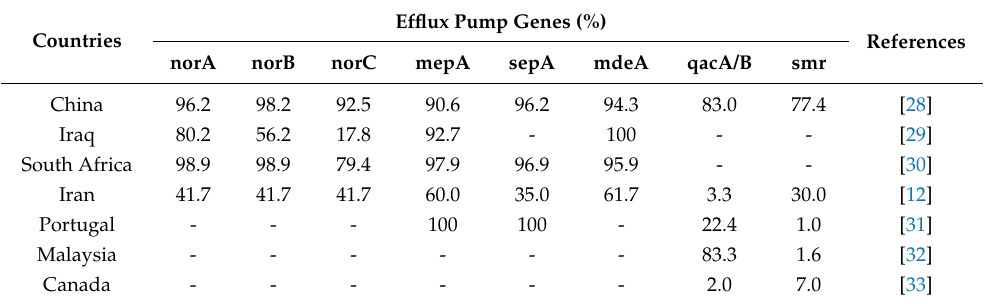
Table 5. Frequency of different efflux pump genes in S. aureus reported among different countries.